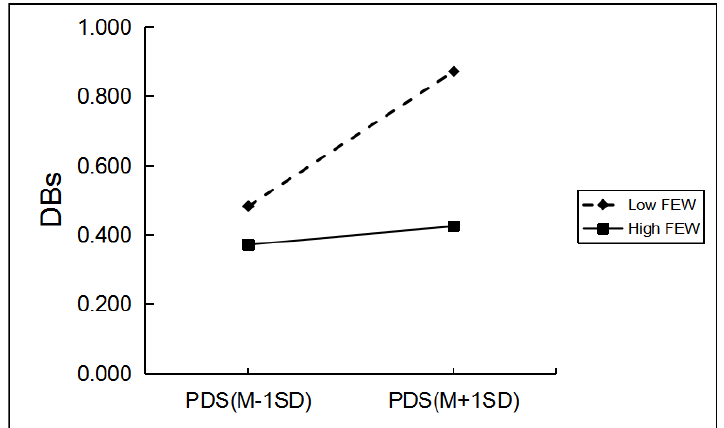
Figure 2. The two-way interaction between PT and FEW in predicting boys’ DBs. Note: PDS, the total score of pubertal development scale; FEW, father emotional warmth; DBs, drinking behaviors.